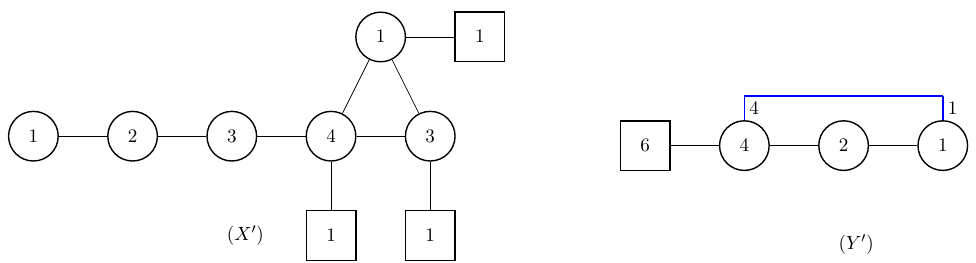
Figure 11 . The quiver X 0 is the 3d mirror of D 4 (SU(6)) reduced on a circle, constructed from a class S prescription. The quiver Y 0 is the 3d mirror of X 0 , i.e. a Lagrangian realization of the SCFT obtained by the reduction of D (SU(6)) on a circle. 4